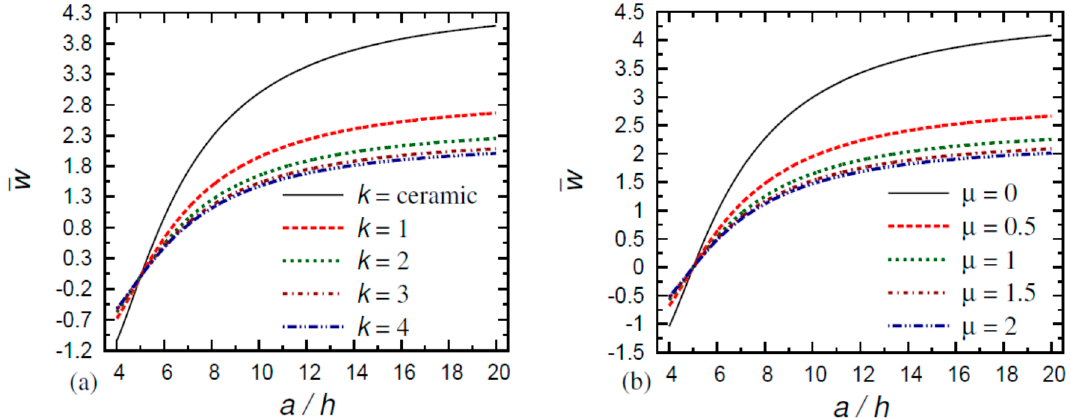
Figure 3. Variation in non-dimensional displacements w of FG square nanoplates versus the thickness ratio a / h , z / h = 0 ( a ) for di ff erent values of k ( µ = 0.5) and ( b ) for di ff erent values of µ ( k = 1).